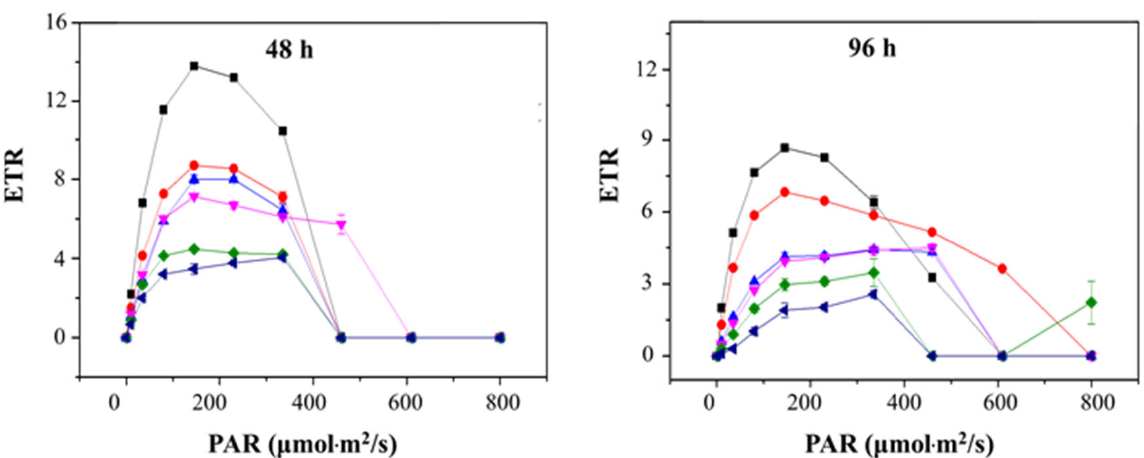
Figure 6. The change in chlorophyll parameters of S. obliquus with the dosages of 0, 10, 50, 80, 120, and 180 µ g/L. PAR, photosynthetic active radiation; Y (II), actual photosynthetic efficiency; NPQ, non-photochemical quenching coefficient; Y (NO), quantum yield of non-regulatory energy dissipation; ETR, relative electron transfer efficiency.